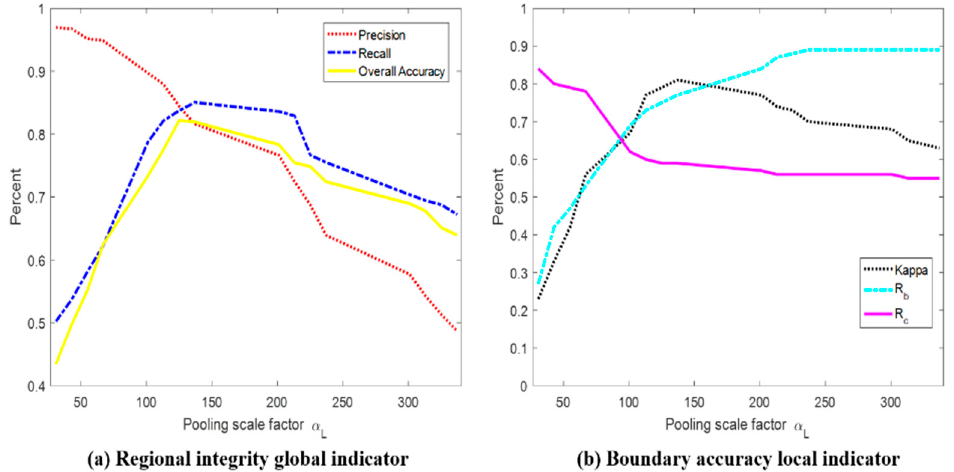
Figure 9. The performance discussion of different scale factor α L setting with single pooling scale description. ( a ) shows the global indexes for regional integrity evaluation, ( b ) shows the local refined indexes for boundary accuracy evaluation.